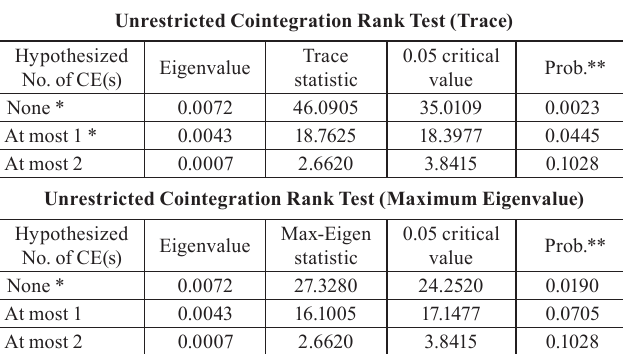
The results of generalized impulse response analysis confirm that the Lithuanian and Estonian stock markets are more interre